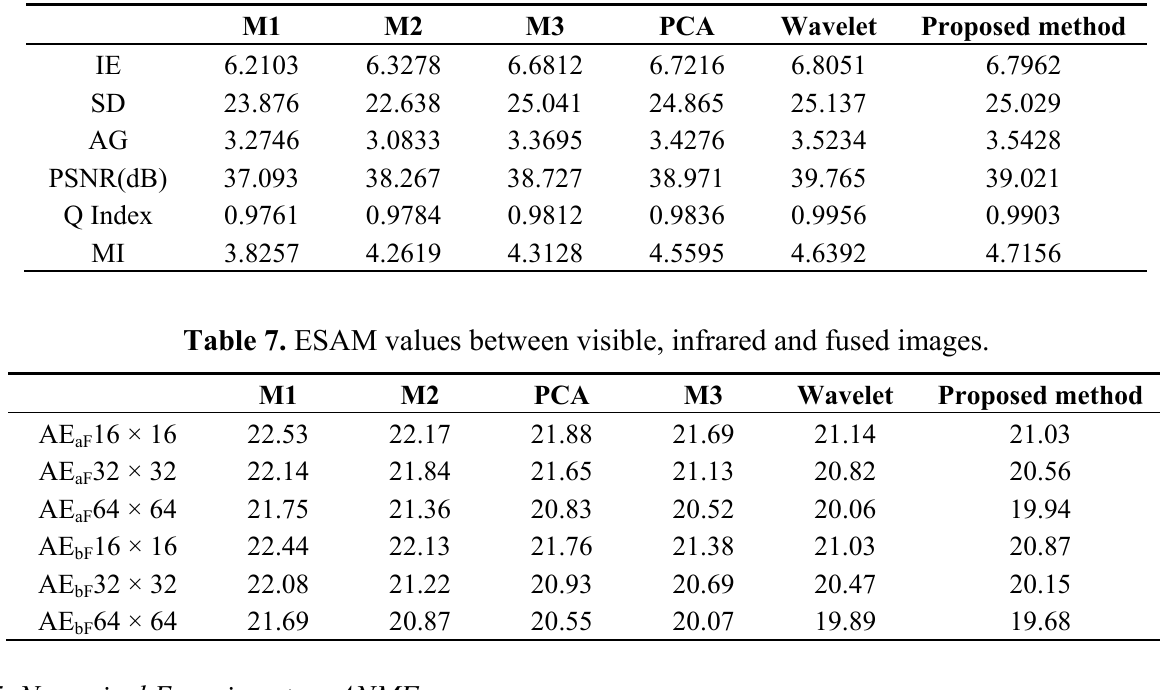
Table 6. Comparison of the fusion methods for visible and infrared images.